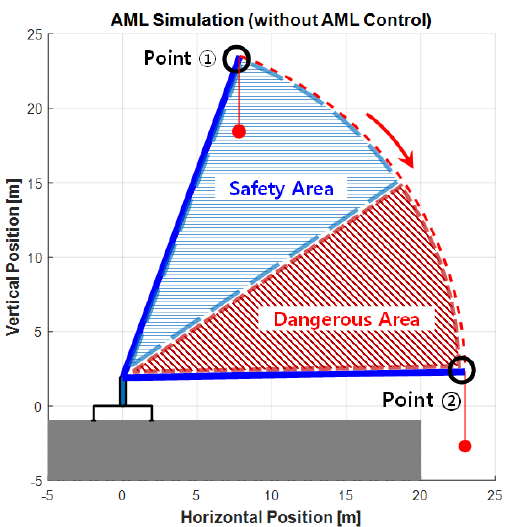
Figure 10. AML simulation outputs without control.